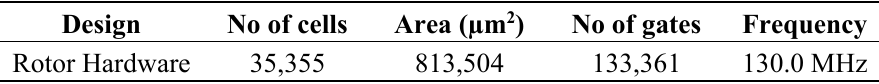
Table 1. GA-Coprocessor/Rotor hardware (area,